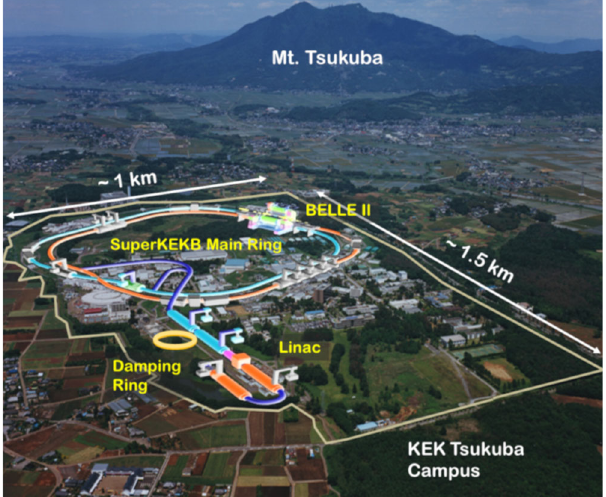
FIG. 1. SuperKEKB at KEK Tsukuba